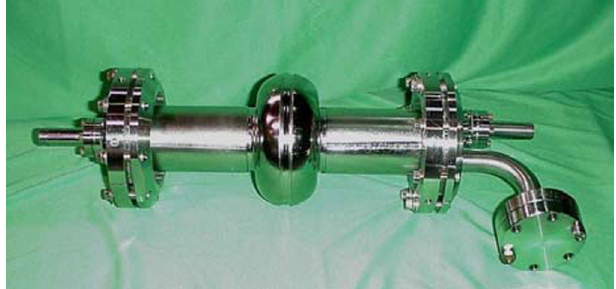
FIG. 2. Single cell 2.45 GHz niobium